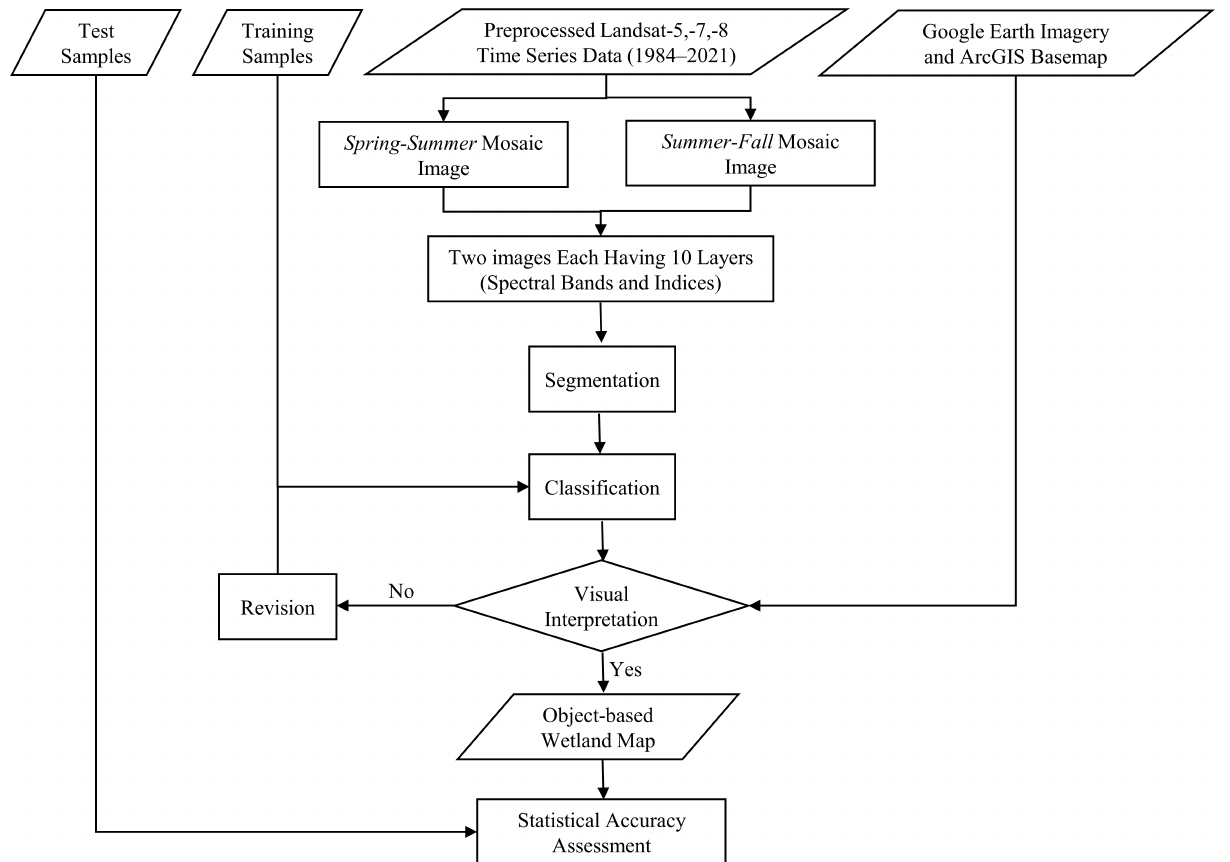
Figure 4. Classification method to produce wetland maps in the Great